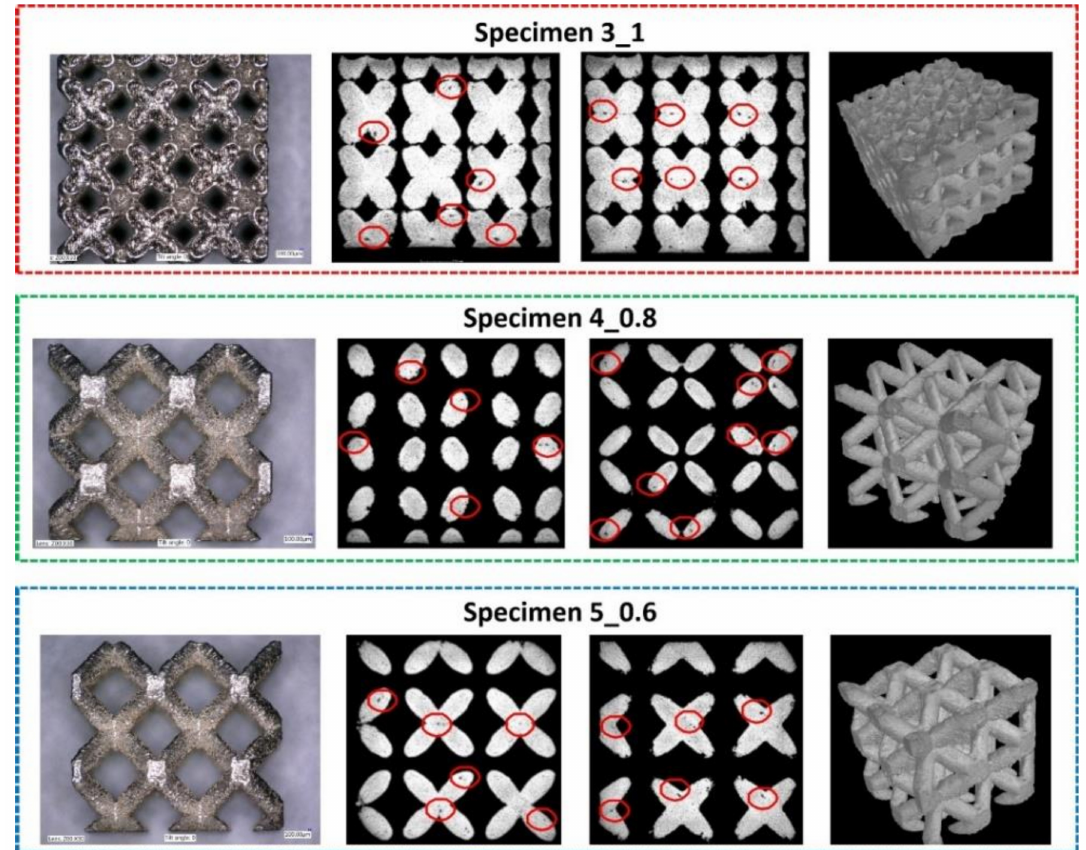
Figure 9. Sample images of structural analysis of lattice structure specimens with the use of